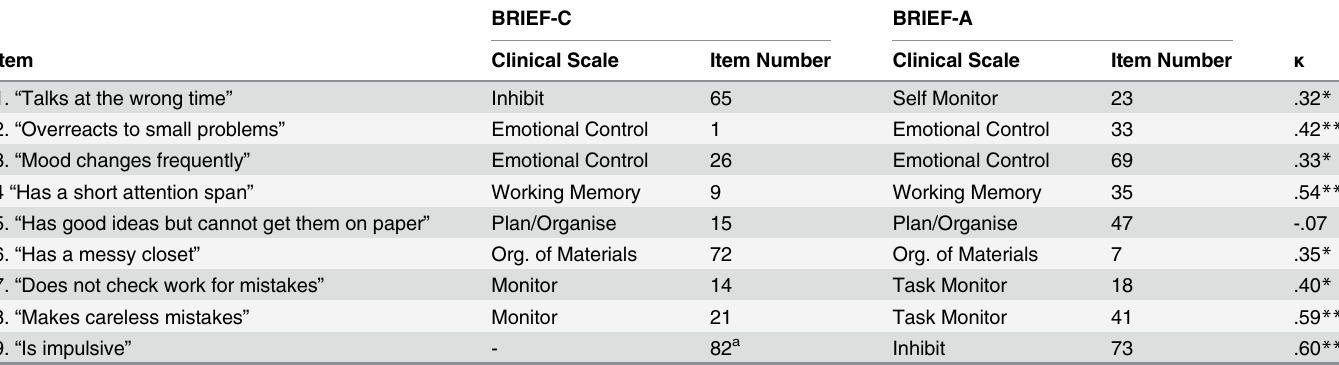
Table 2. Measurement of agreement between the identical items on the BRIEF-C and the BRIEF-A.